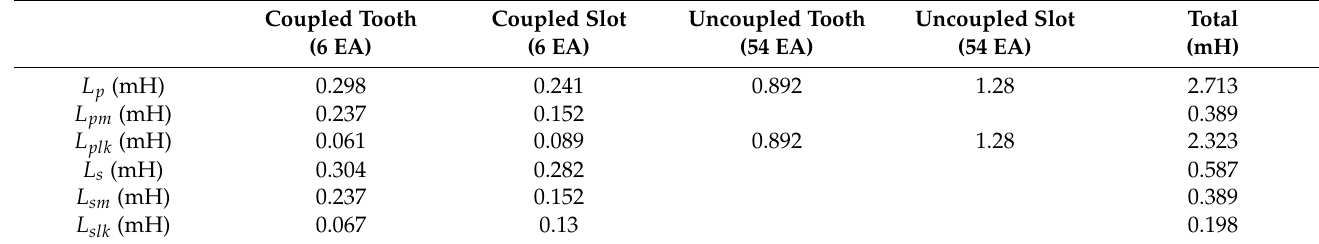
Table 2. The inductance for each part by 2D FEA simulation.